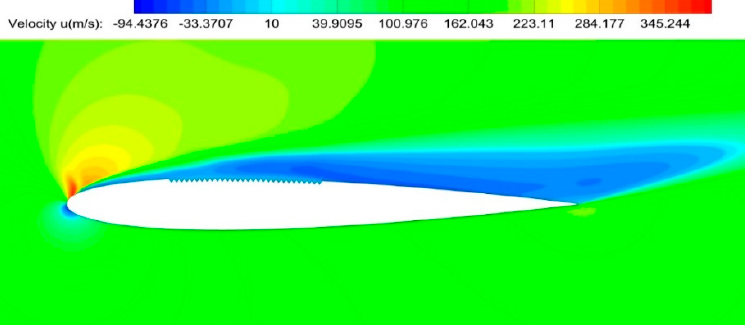
Figure 26. t = 0.1 s, velocity distribution of NACA0012 airfoil with grooves on the pressure side at a 10 ° angle of attack. 5. Conclusions In this paper, we studied the plates with triangular concave grooves, triangular protrusion riblets, trapezoidal concave grooves, trapezoidal protrusion grooves, and arc concave grooves, and compared them with the flat plate. The influences of the grooves and riblets for the flow parameters of the two-dimensional flow area were analyzed. After studying the plates with grooves and riblets, the triangular concave grooves were combined with the standard NACA0012 airfoil to analyze the influence of the triangular concave grooves on the aerodynamic characteristics. After a series of calculations and analyses, the following research results were obtained: The lateral riblets and grooves had a significant effect on reducing frictional resistance, and the trapezoidal concave grooves had the best effect on reducing frictional resistance. Frictional resistance was mainly generated on the windward side of the riblets and grooves, and vortices were generated inside the grooves. On the one hand, these vortices change the flow direction of the airflow in the grooves, resulting in negative shear stress in the grooves, which reduced the total frictional. On the other hand, the vortices play an “air bearing” effect, which converts sliding friction into rolling friction to reduce frictional resistance. The groove and riblet structure also had a certain effect on the boundary layer. Due to the riblet and groove structure, the thickness of the boundary layer increased, the average speed gradient was reduced, and the frictional resistance was reduced. Besides, the lateral riblets and grooves caused additional pressure resistance. Geometry and speed had a great influence on pressure resistance. Due to the geometric shape of the circular groove, a large pressure resistance will be generated, and when the speed reaches the transonic speed, the pressure resistance of the trapezoidal protrusion will increase greatly. Therefore, in the future, the factors that affect the additional pressure resistance will be deeply explored to achieve the purpose of reducing the total resistance. After the triangular concave groove is introduced on the suction side, the aerodynamic characteristics of the airfoil at a small angle of attack will be weakened, but the aerodynamic